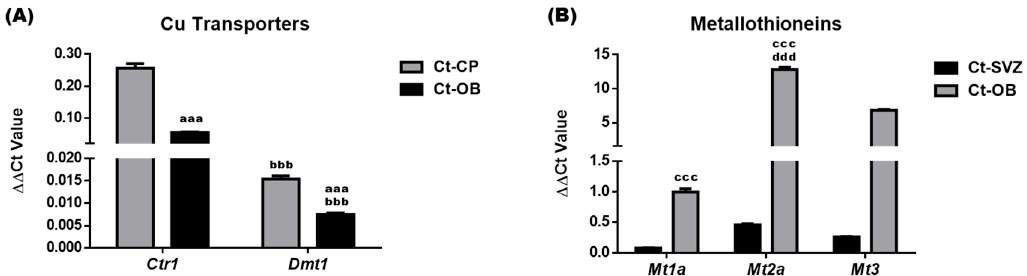
Figure 8. mRNA expression of Cu regulatory proteins in control rats. Expressions of mRNA encoding Cu regulatory proteins were quantified by qPCR. ( A ). ∆∆ Ct values of Cu transporters Ctr1 and Dmt1 in the control CP and OB. ( B ). ∆∆ Ct values of metallothioneins Mt1a, Mt2a, and Mt3 in the control SVZ and OB. Data represents mean ± SEM, n = 6–7/group. aaa: p < 0.001, as compared with the Ct-CP; bbb: p < 0.001, as compared with the correspondent Ctr1 ∆∆ Ct values of the same tissue; ccc: p < 0.001, as compared with the Ct-SVZ; ddd: p < 0.001, as compared with the correspondent Mt1a ∆∆ Ct values of the same tissue; eee: p < 0.001, as compared with the correspondent Mt2a ∆∆ Ct values of the same tissue. SVZ: subventricular zone; OB: olfactory bulb.